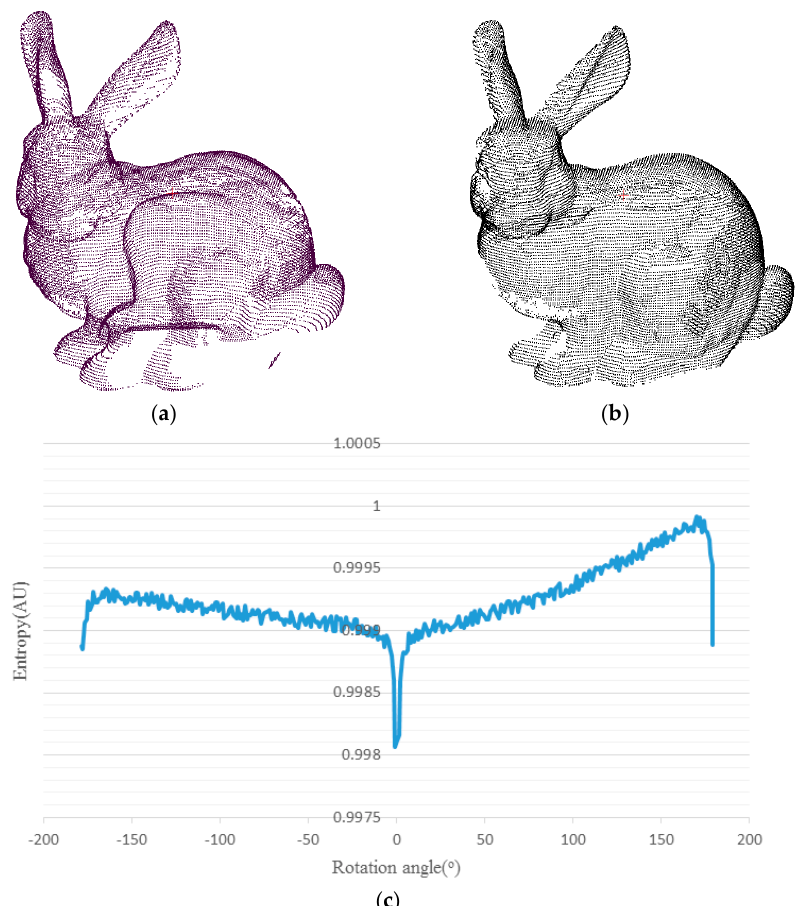
Figure 2. The relation between γ and its corresponding entropy: points in ( a , b ) are previously registered, and the entropy is calculated when points in ( b ) are being rotated γ degrees around the z axis. The entropy change with γ is recorded in ( c ).